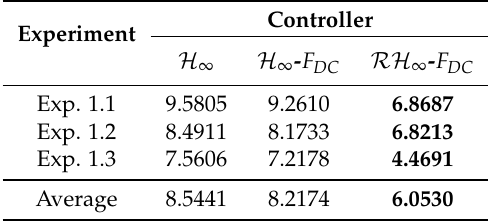
Table 3. Integral of absolute errors, E IA (rad), from each method for Experiments 1.1, 1.2, and 1.3. The least error for each row is written in